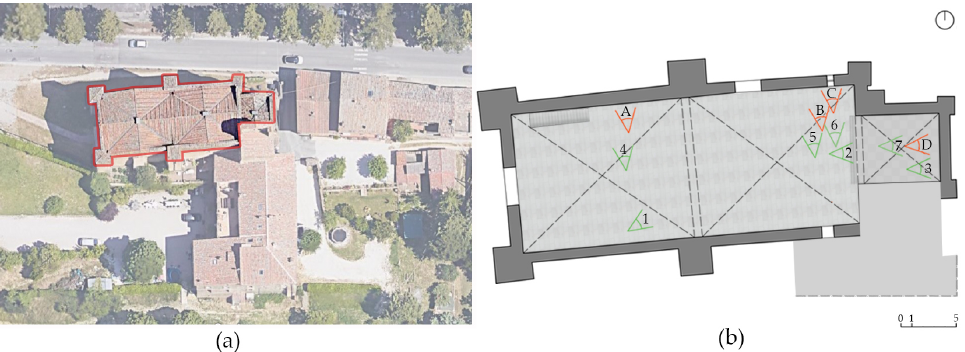
Figure 2. ( a ) Aerial view of the architectural complex of San Bevignate, the border of the church is highlighted in red lines. ( b ) Plan of the Templar church with the photographic cones of vision chosen for the survey: in red the settings of thermographic shootings, in green the digital photography